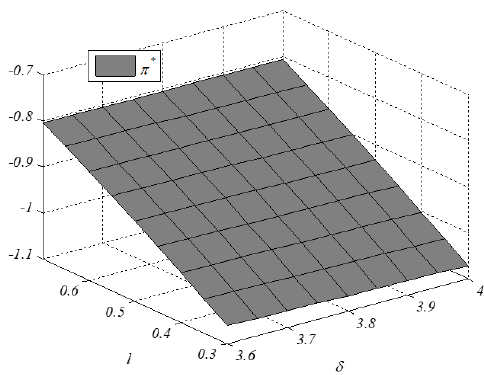
Figure 6. Changes in social benefit.